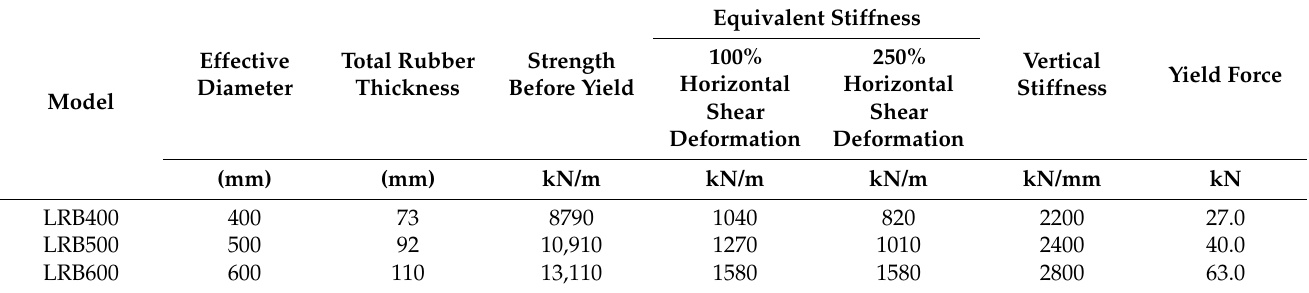
Table 1. Product specification of rubber